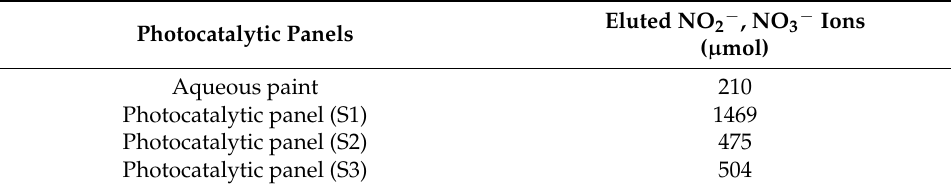
Table 10. Washing water field test results of photocatalytic panels.